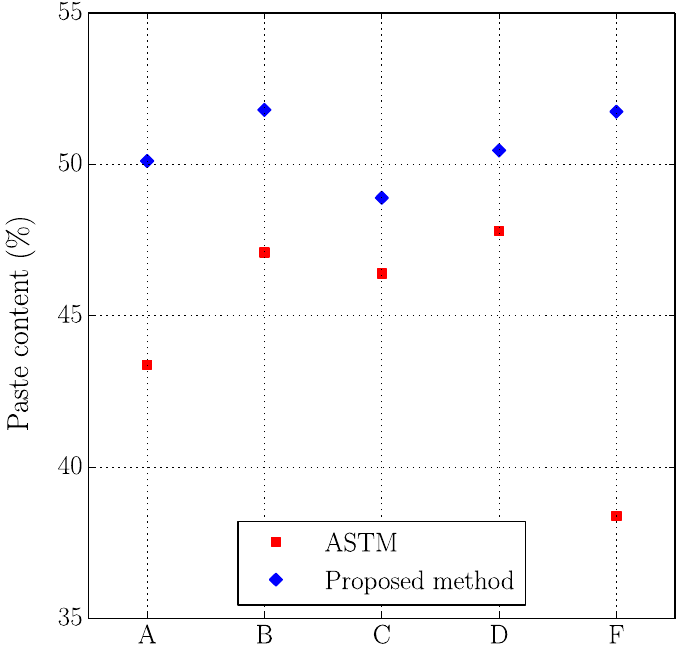
Figure 11. Results of the paste content (%) of the slabs studied using the original and the proposed methods.